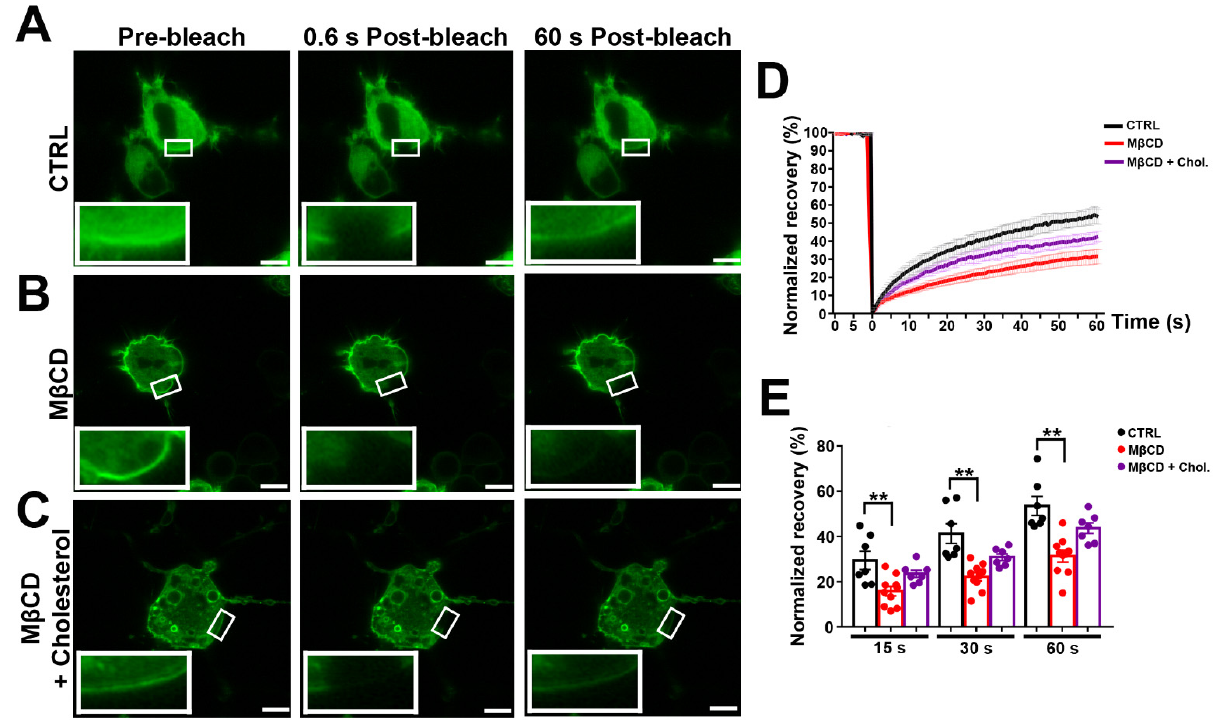
Figure 4. Cholesterol depletion reduces lateral mobility of Panx1 in the membrane. N2a cells transiently expressing mPanx-1-GFP were subjected to treatment with 5 mM methyl- β -cyclodextrin (M β CD), 5 mM M β CD followed by addition of cholesterol (M β CD + Chol) or left untreated (CTRL). ( A – C ) Fluorescence images of transfected cells (control and treated with M β CD alone or with cholesterol) before (pre-bleach) and at 0.6 and 60 s postbleach; bleached regions are shown at higher magnification in insets. Bars: 10 µm; inset magnification 3×. ( D ) FRAP recovery curves for control cells and with M β CD alone or with cholesterol. ( E ) Histograms of normalized FRAP recovery at 15, 30, and 60 s after photobleach. p values obtained from ANOVA test followed by Dunnett’s test. n = 7–10 per plasma membrane domain, data collected over four independent repeats. ** p < 0.01.